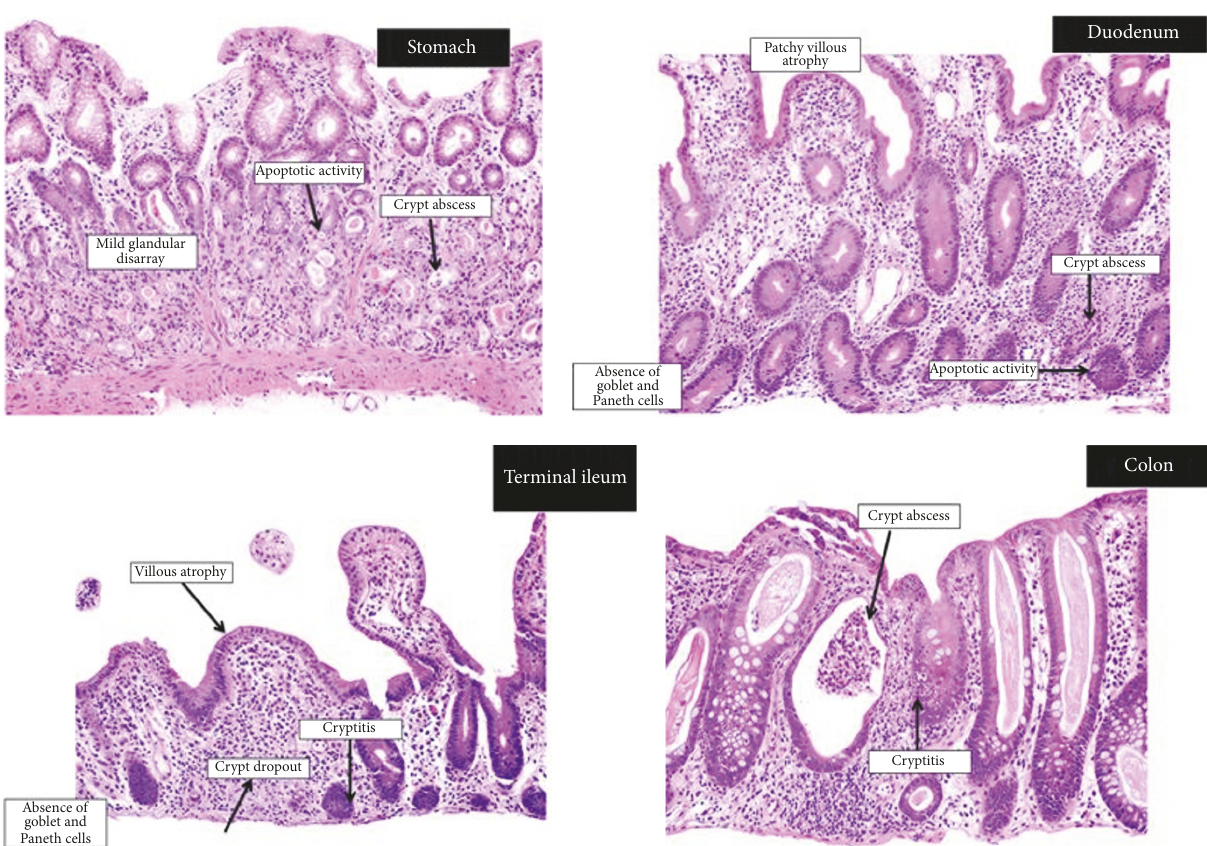
Figure 3: Biopsies of the stomach show loss of parietal cells, mild glandular disarray, acute inflammation, and apoptotic activity (hematoxylin and eosin, original magnification 200x); biopsies of the duodenum show absence of goblet cells and Paneth cells (hematoxylin and eosin, original magnification 200x); biopsies of the terminal ileum are similar to the duodenum. There is an absence of goblet cells and Paneth cells. This field shows crypt dropout as well (hematoxylin and eosin, original magnification 200x); biopsies of the colon show cryptitis and crypt abscess with minimal crypt